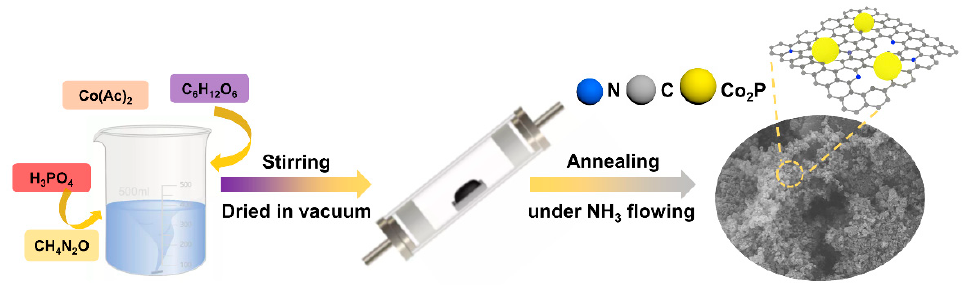
Figure 1. Schematic of the synthesis of Co 2